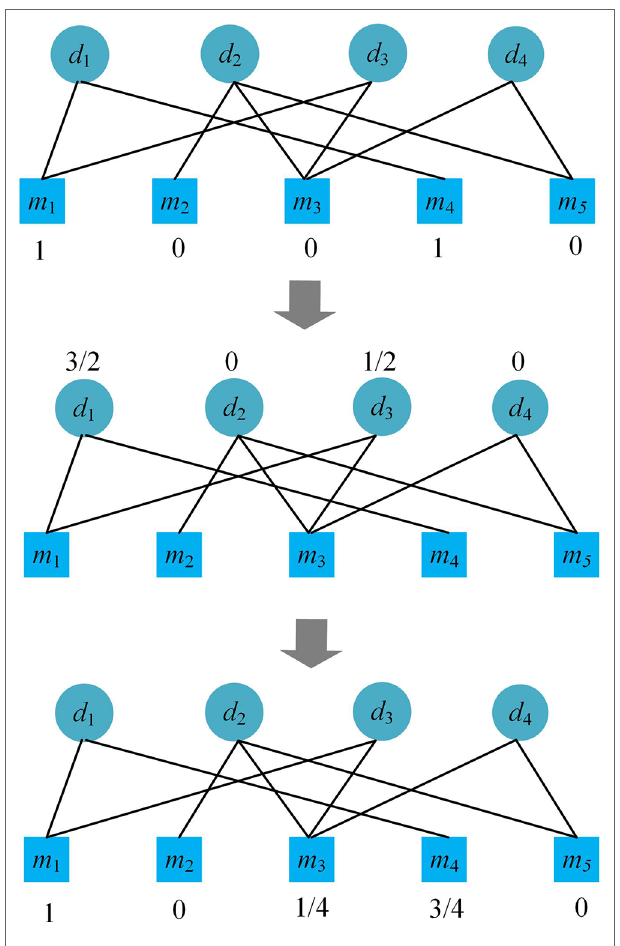
FIGURe 1 | Illustration of the two-step resource-allocation process in a bipartite graph.